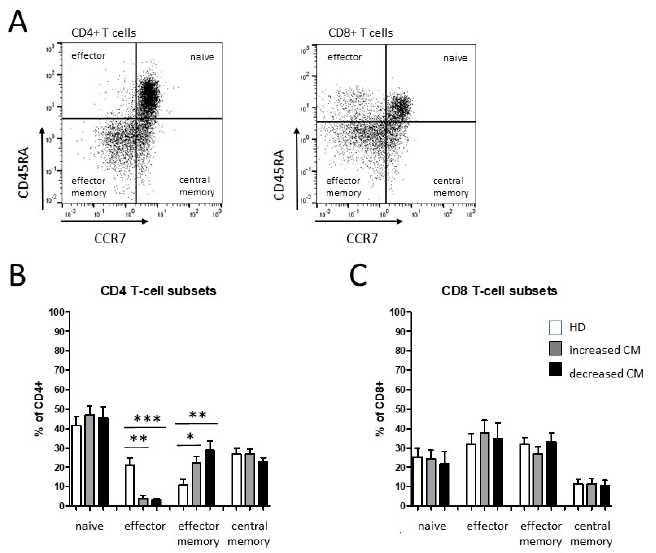
Figure 4. Flow cytometric analysis of CD4 + and CD8 + T-cell subset distribution in PBMCs from healthy donors and oropharyngeal cancer patients. ( A ) Example gating scheme of CD4 + and CD8 + T-cell subsets from one representative patient. Based on expressions of CD45RA and CCR7, naïve (CD45RA + CCR7 + ), central memory (CD45RA − CCR7 + ), effector memory (CD45RA − CCR7 − ), and effector (CD45RA + CCR7 − ) T cells were identified. ( B ) Percentages of naïve, effector, effector memory, and central memory T cells within CD4 + and CD8 + T cells ( C ) from healthy donors and OPC patients with increased and decreased levels of classical monocytes (CM). * p < 0.05; ** p < 0.01; *** p < 0.001.